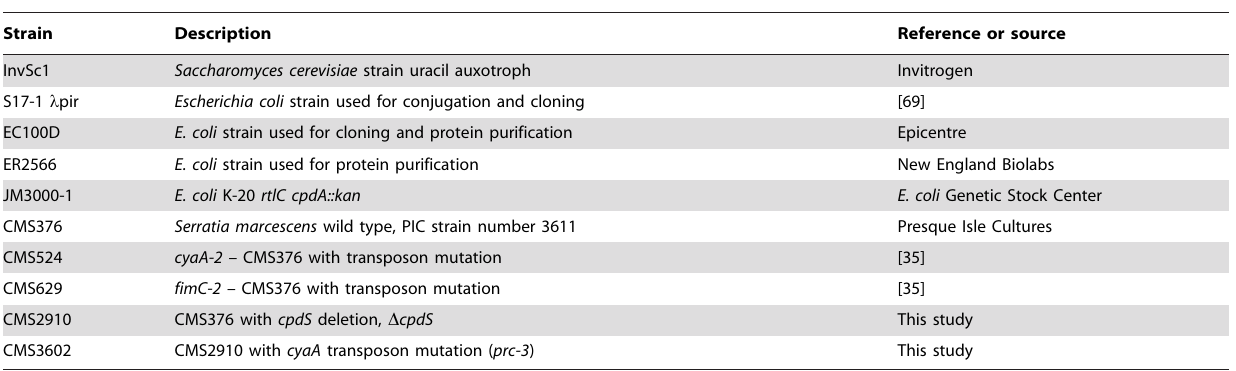
Table 1. Strains used in this